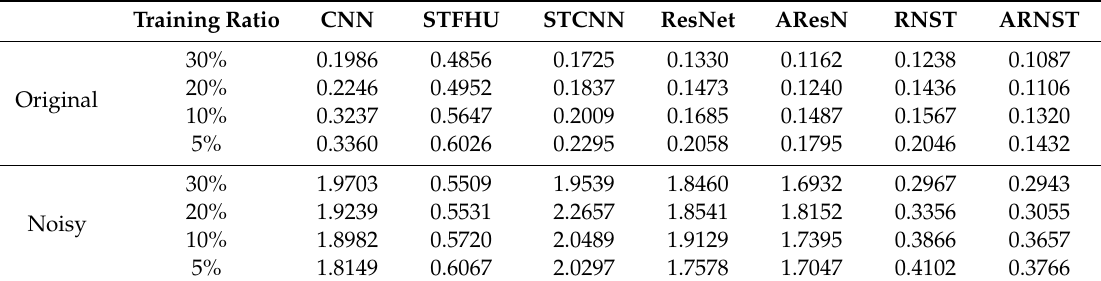
Table 4. Summations of RMSE with small training ratios for the Jasper Ridge dataset.